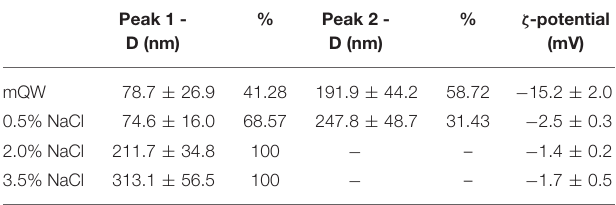
TABLE 1 | Characterization of CuO NP dispersions in milli-Q water (mQW, T = 25 ◦ C) and three saline solutions used as exposure media ( T = 25 ◦